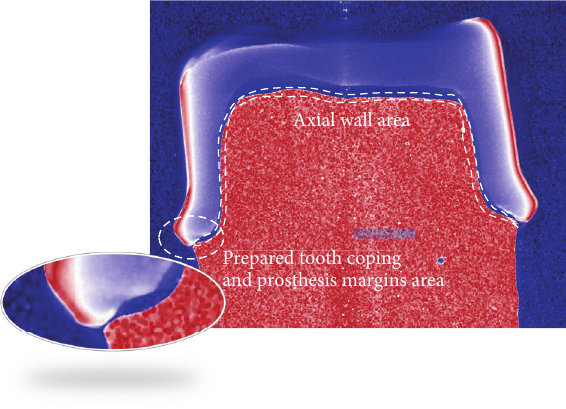
Figure 6: Anatomical element